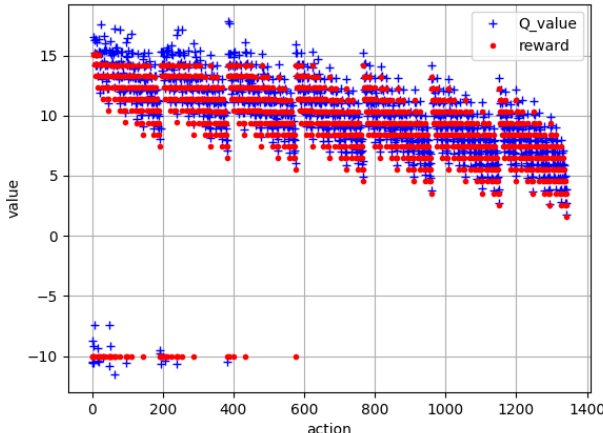
Figure 10. Comparison chart of Q value and reward value (25000 times of training).